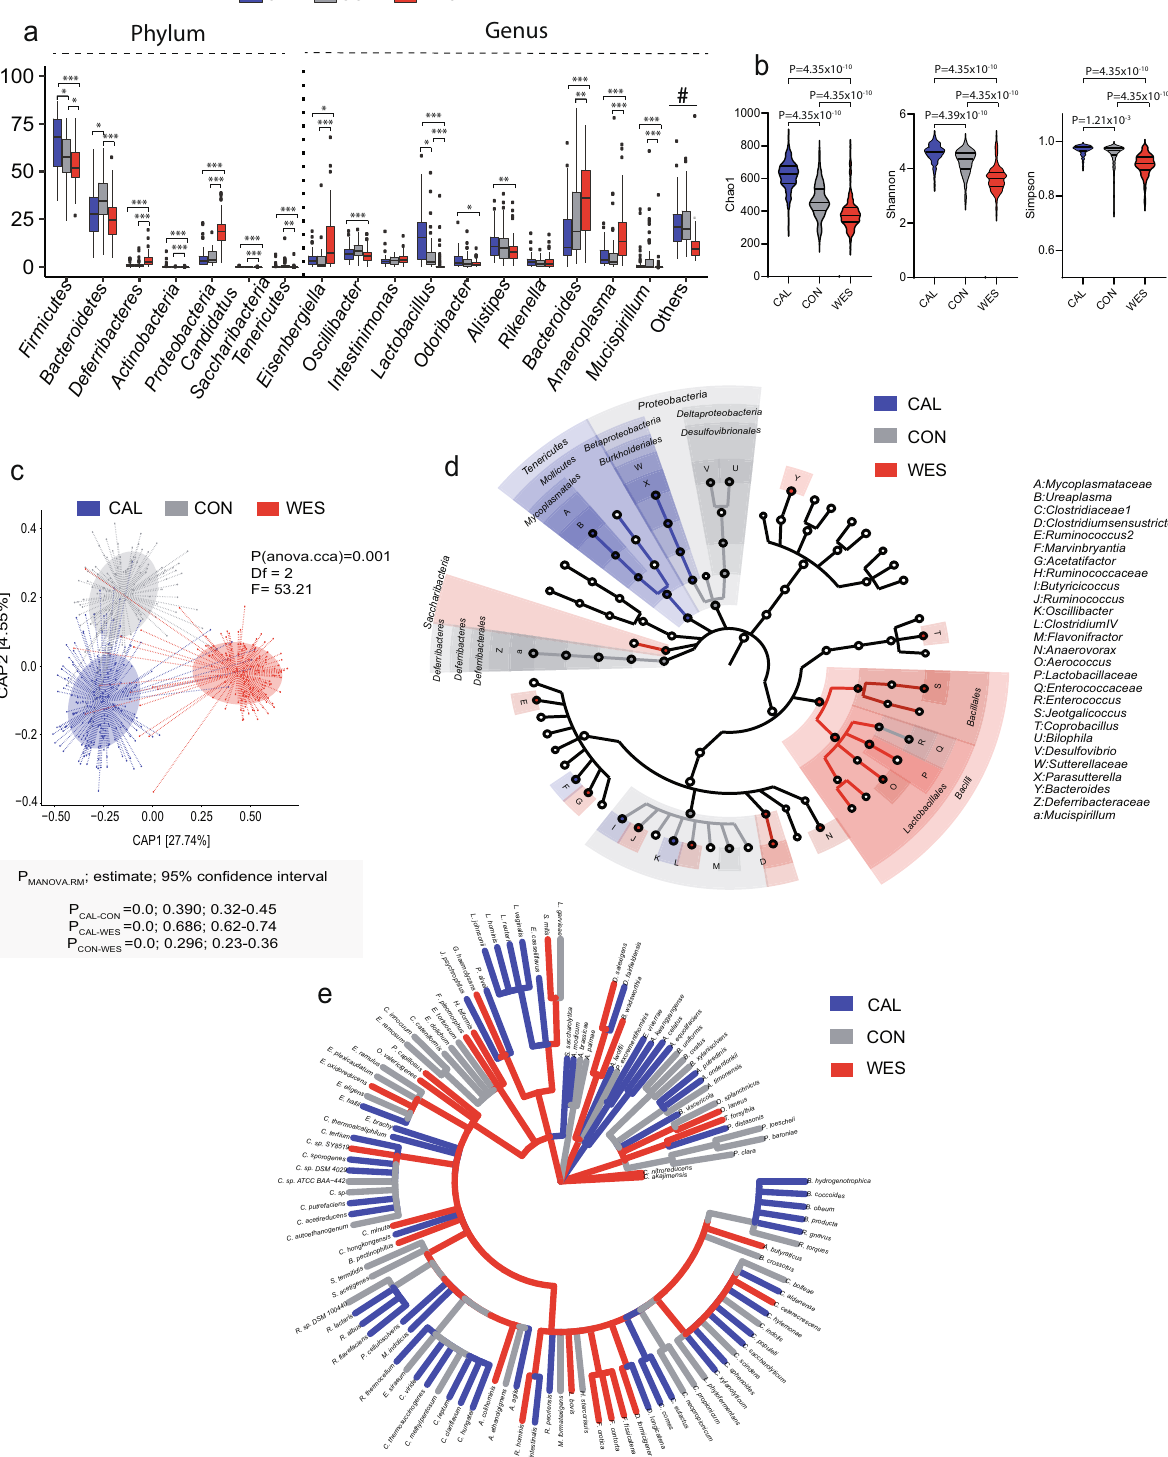
A:Mycoplasmataceae B:Ureaplasma C:Clostridiaceae1 D:Clostridiumsensustricto E:Ruminococcus2 F:Marvinbryantia G:Acetatifactor H:Ruminococcaceae I:Butyricicoccus J:Ruminococcus K:Oscillibacter L:ClostridiumIV M:Flavonifractor N:Anaerovorax O:Aerococcus P:Lactobacillaceae Q:Enterococcaceae R:Enterococcus S:Jeotgalicoccus T:Coprobacillus U:Bilophila V:Desulfovibrio W:Sutterellaceae X:Parasutterella Y:Bacteroides Z:Deferribacteraceae